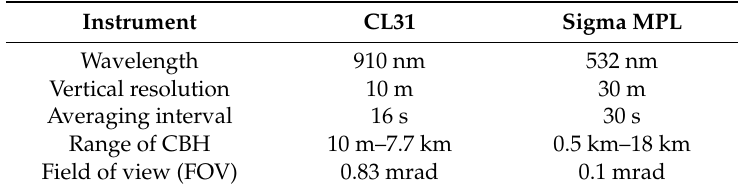
Table 2. Summary of top-level specifications of the ceilometer and the micro-pulse lidar (MPL) at the Atmospheric Radiation Measurements (ARM) SGP site. Note that the lower limit of the MPL cloud base height (CBH) is 0.5 km, whereas it is 10 m for the